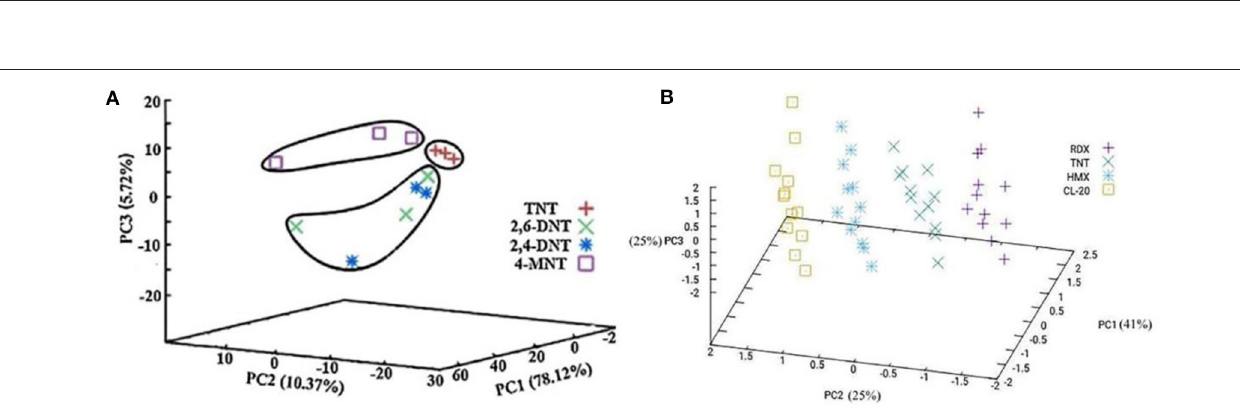
Frontiers in Chemistry |